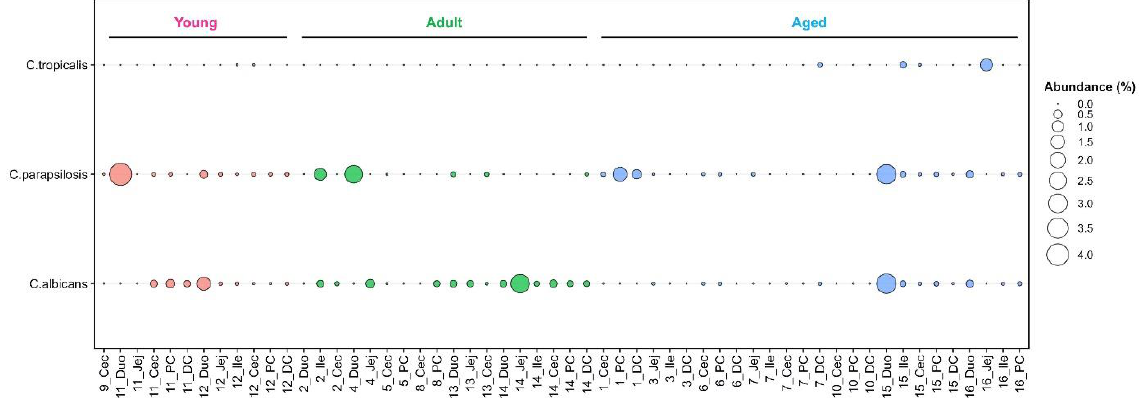
Figure 6. Prevalence and abundance of Candida pathobionts in the captive macaque GIT.